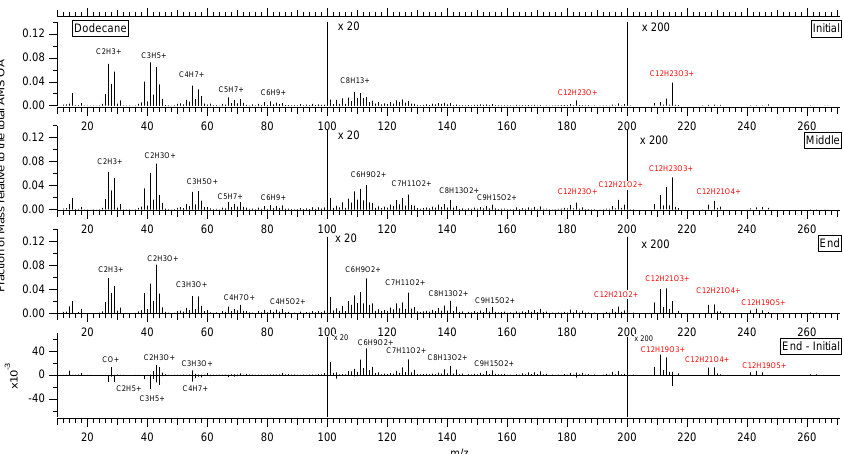
Fig. 4. High-resolution mass spectrum of SOA formed from n -dodecane at initial organic growth, mid-experiment, and end of experiment. The difference spectrum is also shown. m/z 101–200 are multiplied by 20, and m/z 201–300 are multiplied by 200 for visual clarity. Ions with high signal are labeled. Ion labels in red correspond with proposed ion assignments in Table 5.